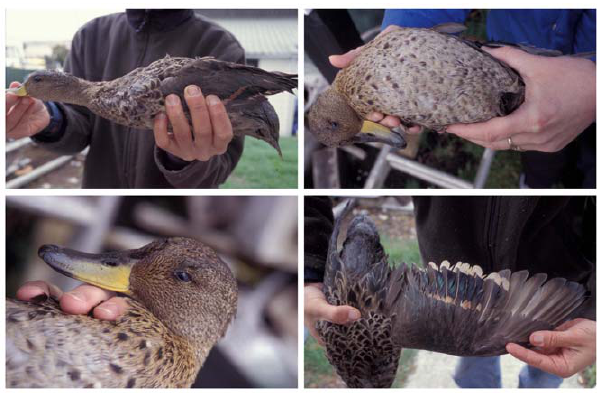
Figure 2. F 1 speckled teal x yellow-billed pintail hybrid (REW 325).